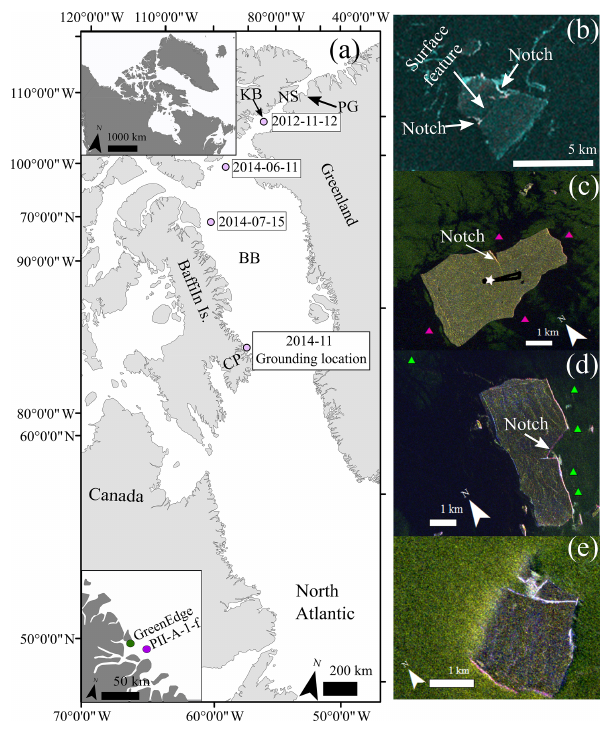
Figure 1. Remote monitoring of PII-A-1-f and data collection lo- cations. (a) Dates and locations of PII-A-1-f as observed with RADARSAT-2 synthetic aperture radar (SAR) observations while the ice island drifted from the Petermann Glacier (PG) and through Nares Strait (NS), Kane Basin (KB), and Baffin Bay (BB) be- fore grounding north of the Cumberland Peninsula (CP). The poly- gon in the top inset shows the location of the larger-scale map. The bottom inset shows the proximity of the grounding location to the GreenEdge sea ice camp. (b) RADARSAT-2 ScanSAR im- age (100m nominal resolution) showing the surface feature and sidewall notches. (c–e) RADARSAT-2 Fine Quad SAR (8m nom- inal resolution) scenes acquired on 27 June 2016, 27 Septem- ber 2016, and 23 September 2017, respectively. CTD (conductiv- ity, temperature, depth) cast locations are denoted by triangles in (c) and (d) , and the star in (c) denotes the location of the sta- tionary ice-penetrating radar and weather station; the ∼ 3km mo- bile IPR transect conducted in May 2016 is shown as a black line. All RADARSAT-2 images are presented as colour composites (ScanSAR polarizations: red is HH and blue and green is HV; Fine Quad polarizations: red is HH, green is VV, and blue is